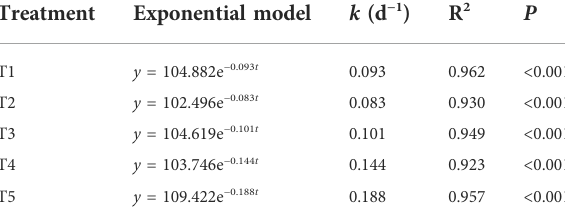
TABLE 2 Exponential simulation of foliar mass remaining rates (Wt/ W0) in the Three Gorges Reservoir, China.